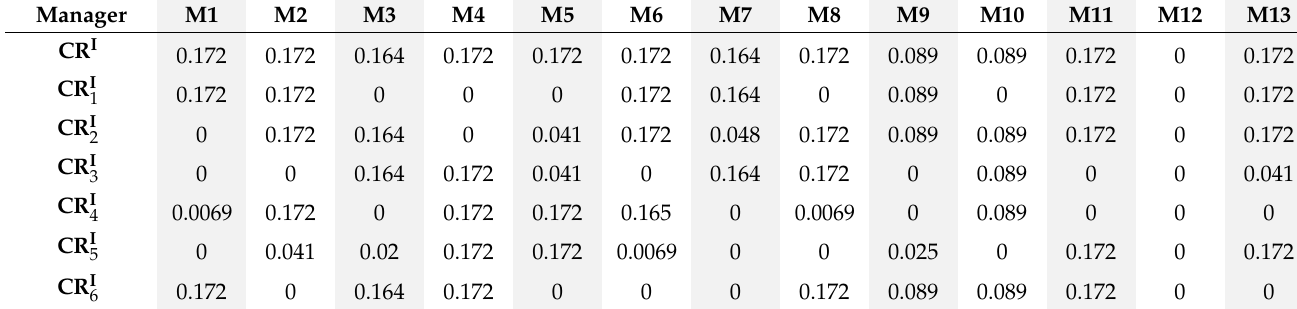
Table 7. Global input-based consistency ratio and the local consistency level of each